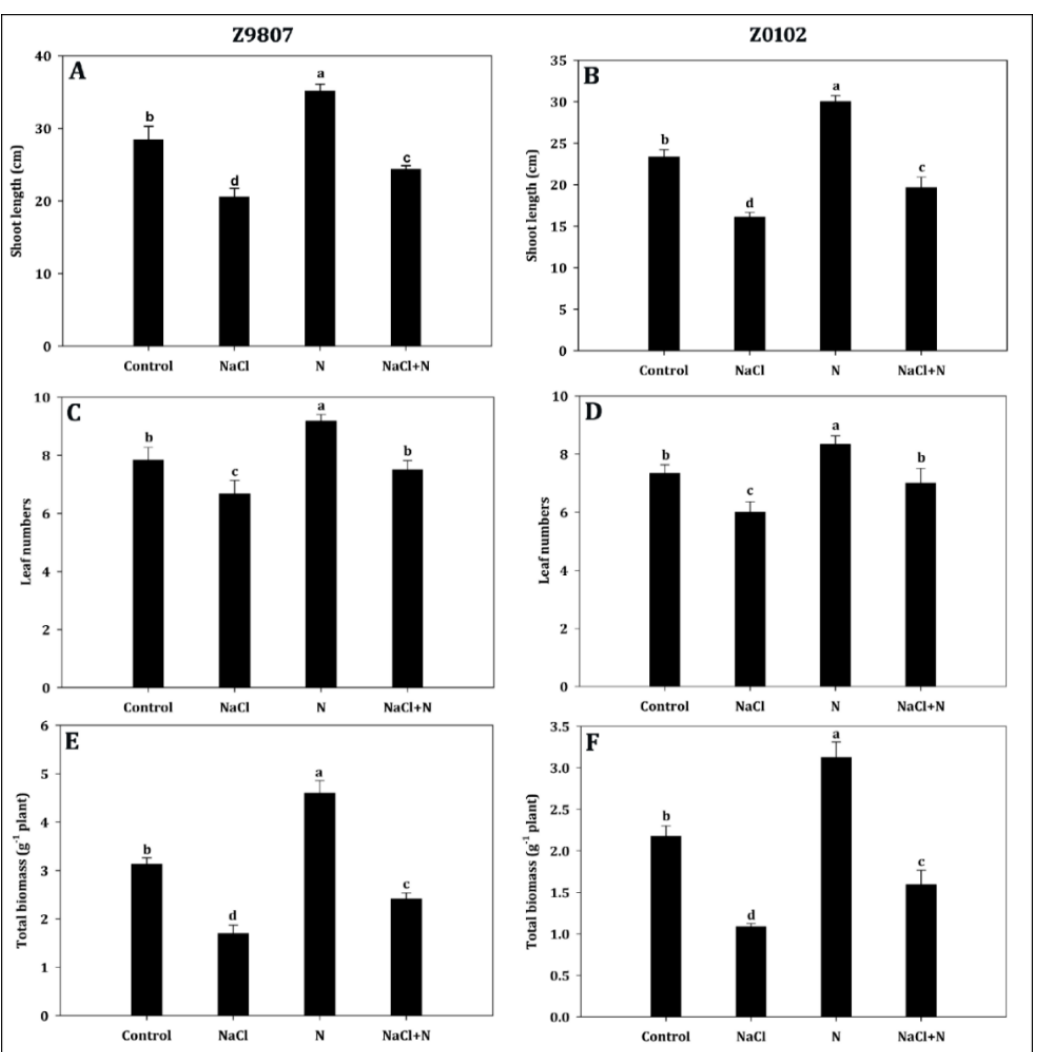
Figure 2. Effect of nitrogen supplementation on ( A , B ) shoot length, ( C , D ) leaf numbers, and ( E , F ) total biomass accumulation in Gossypium hirsutum L. under salinity stress. Data represent the mean of three replicates and bars with different letters denote significant differences at p < 0.05.